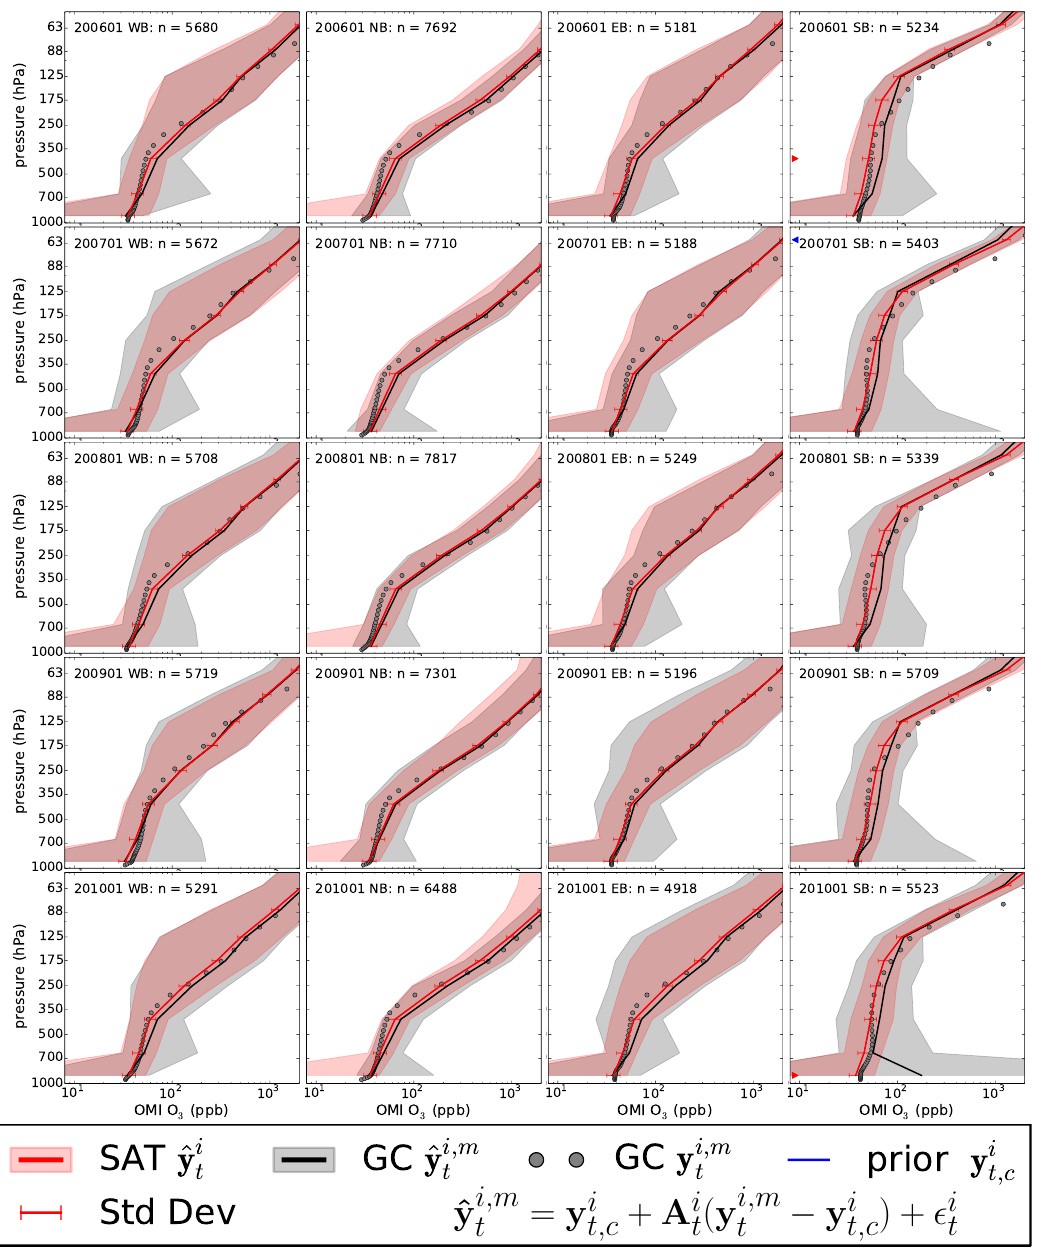
Fig. A3. Same as Fig. A1, but for OMI.